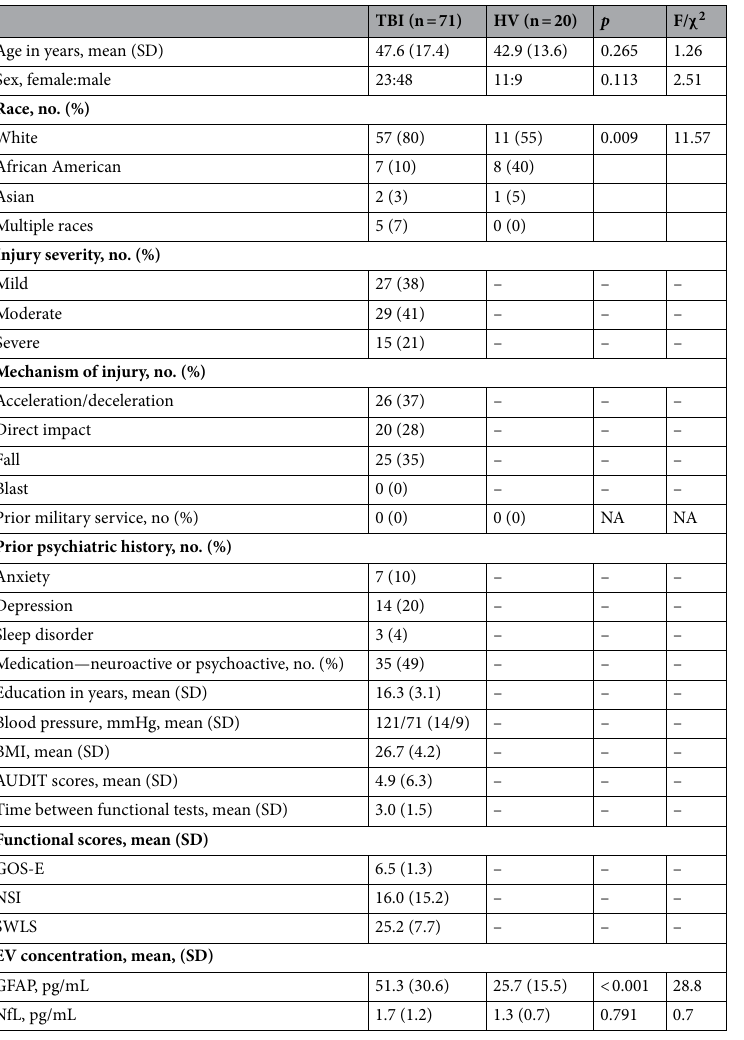
Table 1. Demographics, clinical characteristics, and biomarker concentrations at 1 year. TBI traumatic brain injury, HV healthy volunteer, BMI body mass index, AUDIT Alcohol Use Disorders Identification Test,